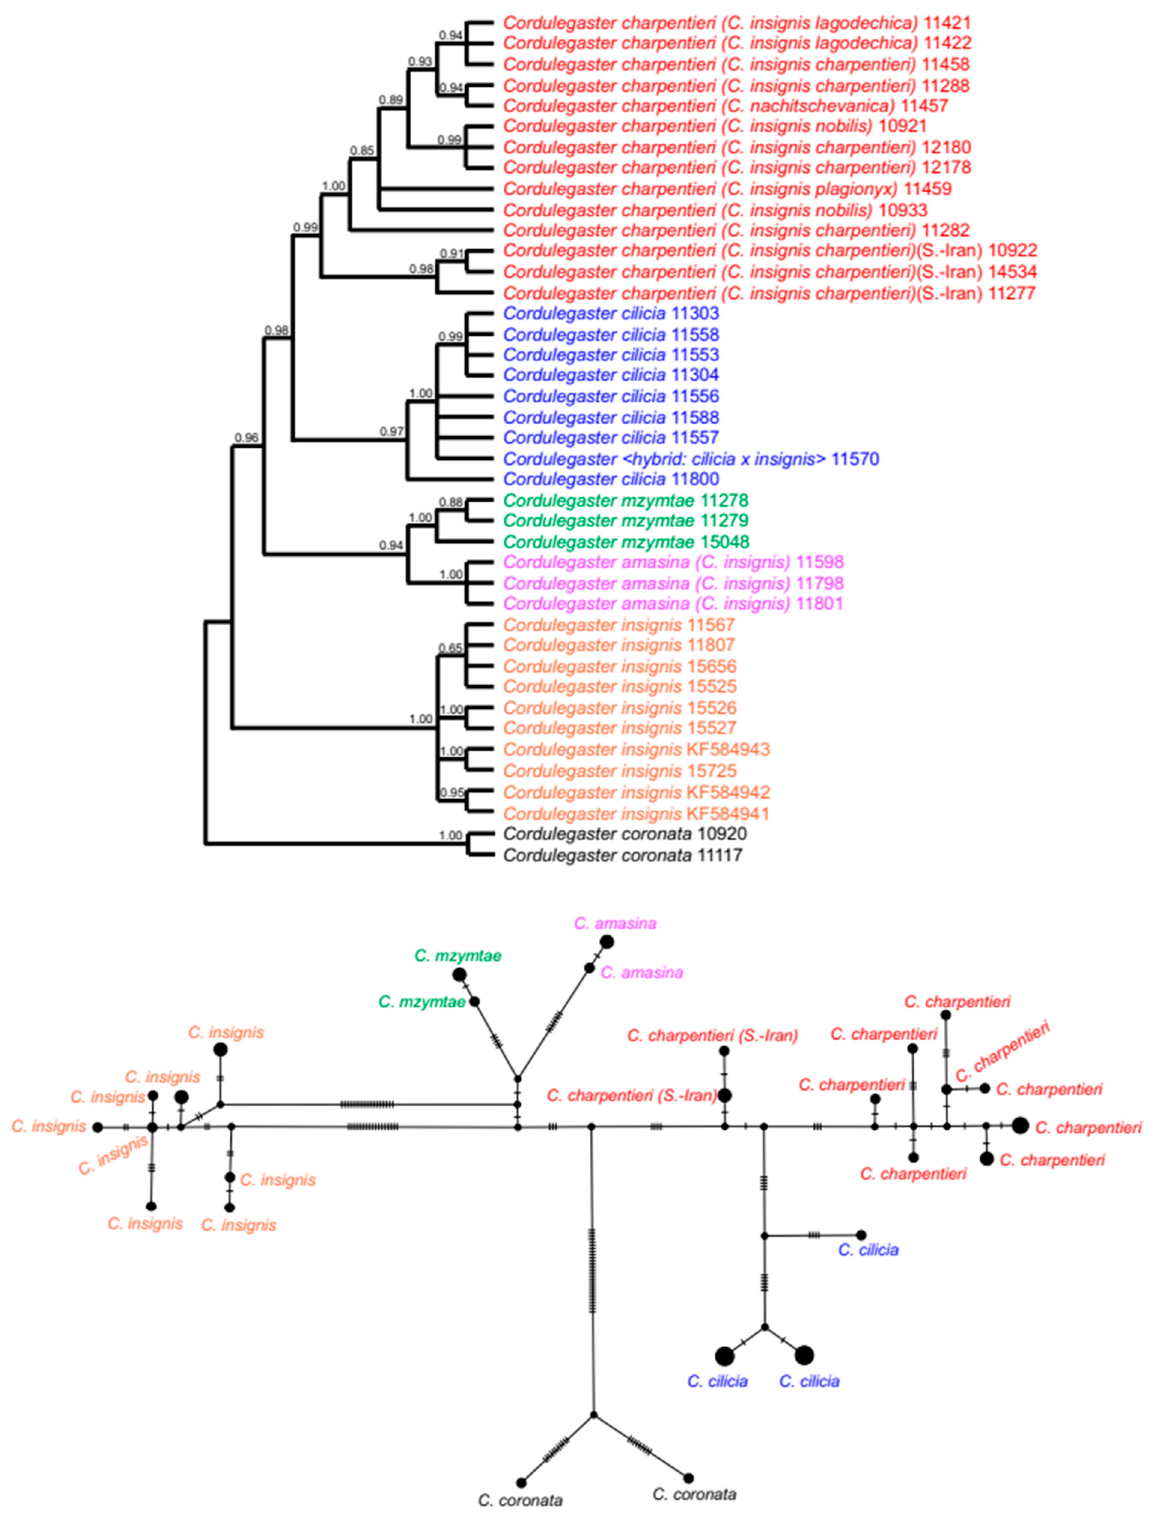
Figure 7. Tree of the COI-analysis for the C. bidentata -complex and C. coronata including haplotype-analysis (TCS-network made in POPART 1.7). Bayesian posterior probabilities are depicted at the nodes.